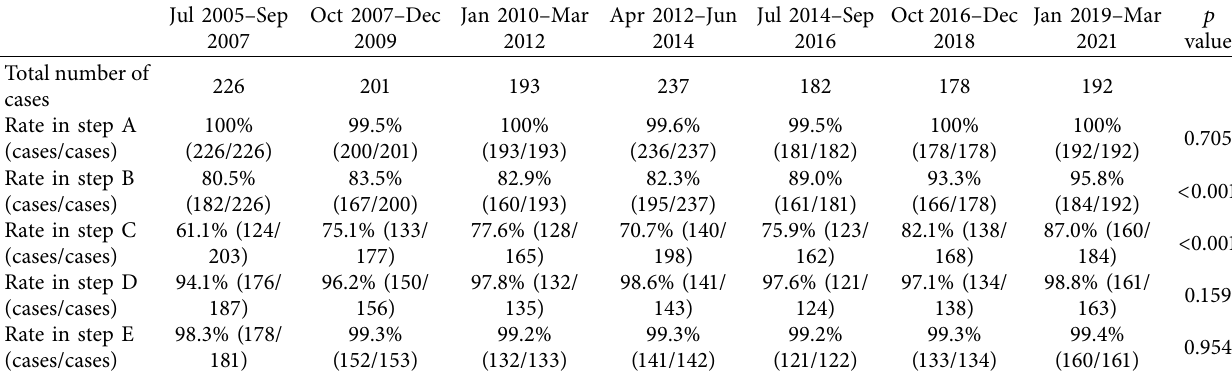
Table 2: Time trend of completion rates in different steps of phacoemulsification performed by